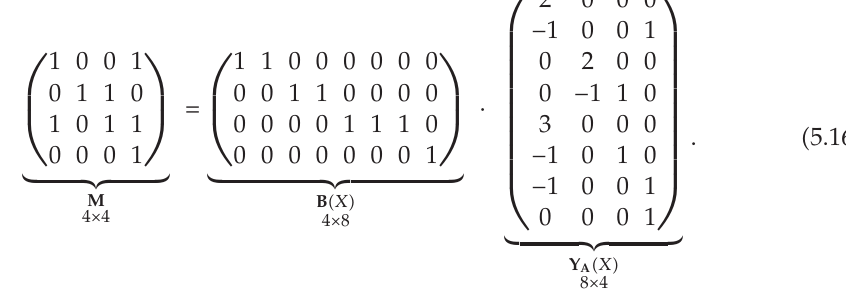
Figure 3 (cid:8) a (cid:9) shows the resulting associated network, where the branch admittance values are indicated as well as the sensed variables to which each branch is associated. Figure 3 (cid:8) b (cid:9) shows a spanning tree T of full rank, in which it can be noted that the four branches that conform the tree are associated to four di ff erent measured variables. Then,